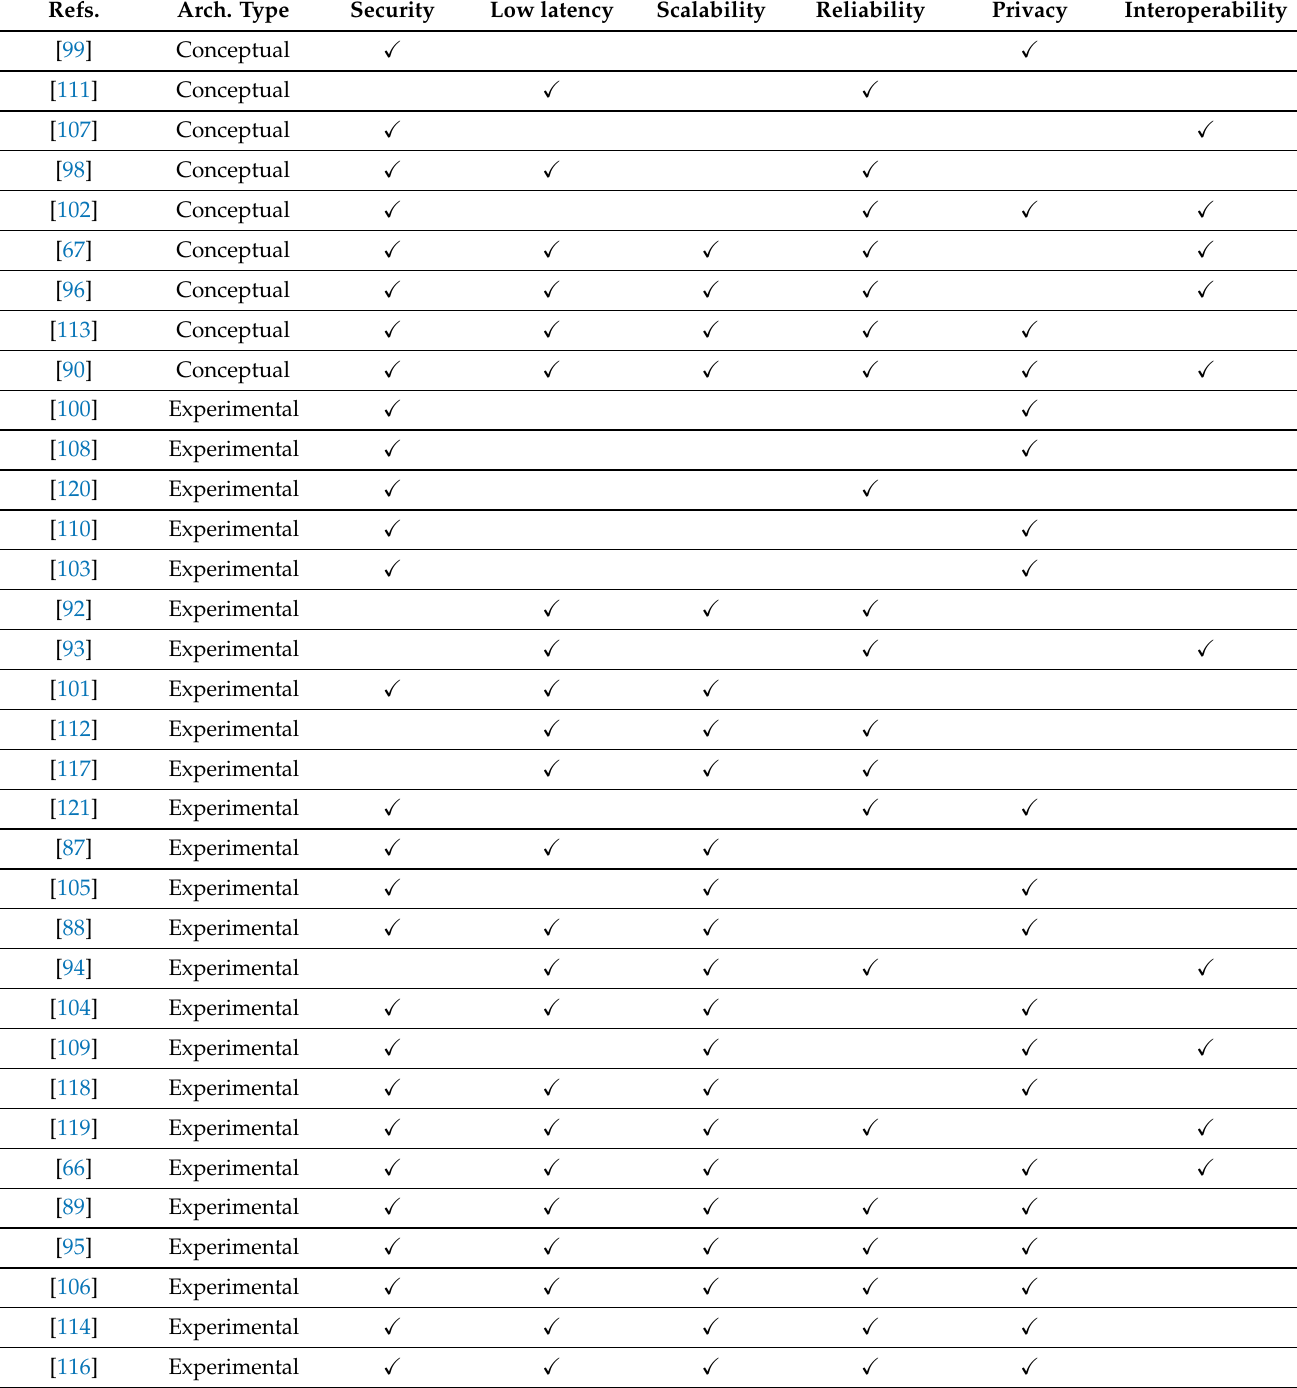
Table 3. Comparison of IIoT architectures in the literature.